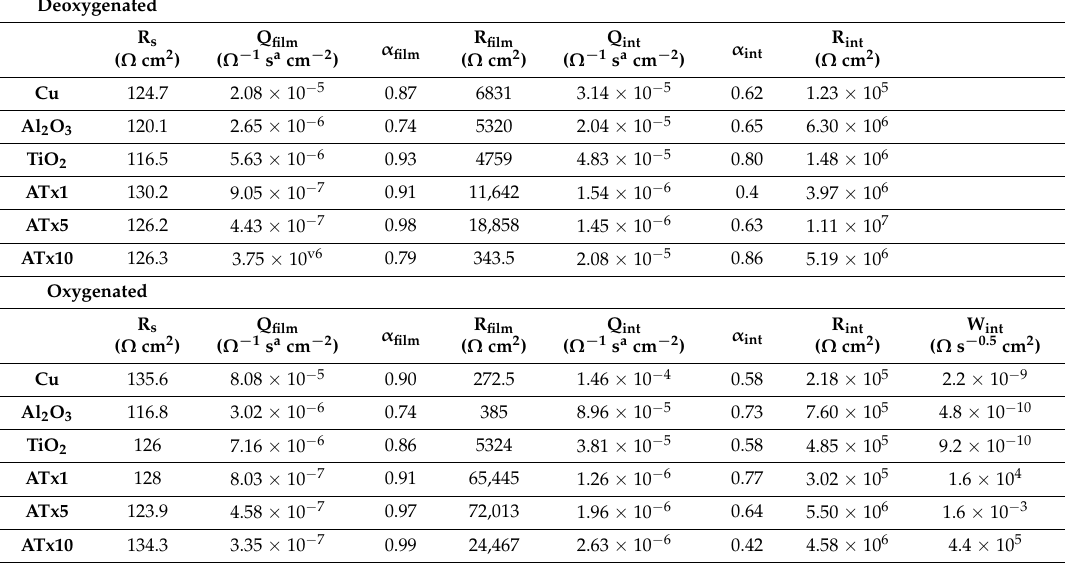
Table 3. Fitted parameters from equivalent electrical circuit modeling of impedance spectra in deoxygenated (Figure 5) and oxygenated (Figure 6) 0.1 M NaCl. Refer to Figure 1 for a depiction of the equivalent circuit and parameter definitions. Q and α are the coefficient and exponent of the constant phase element (see Equation